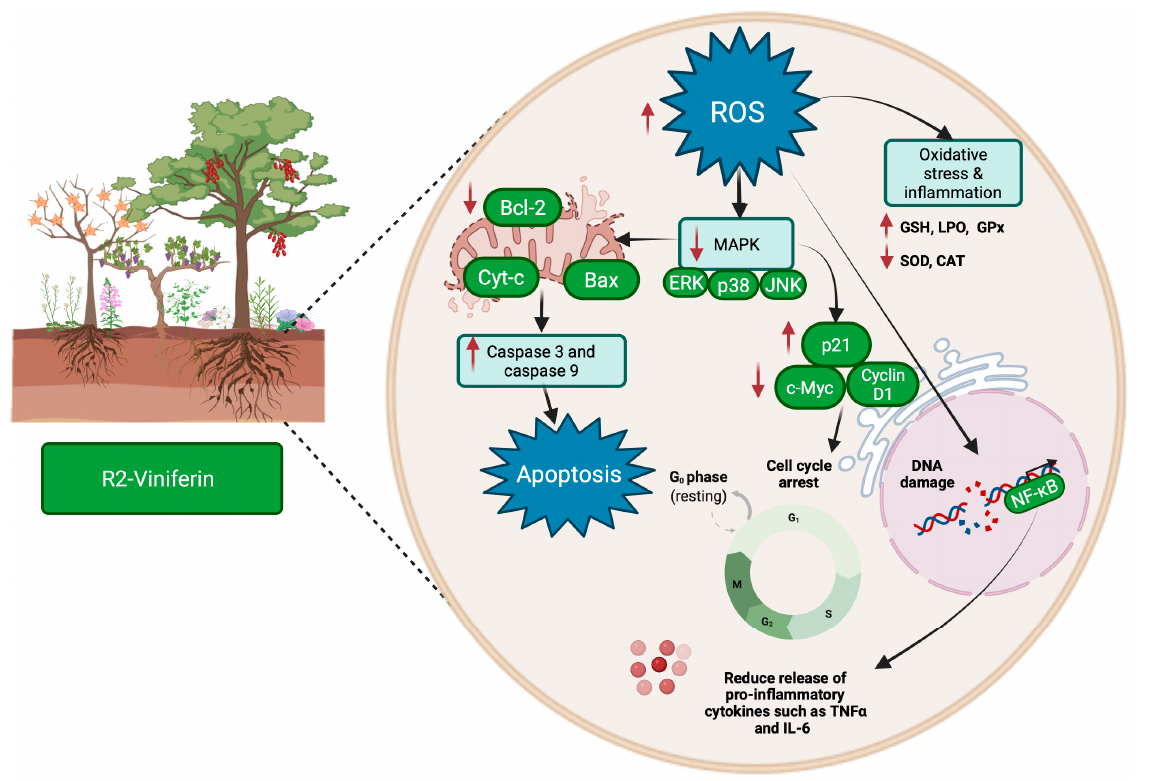
Figure 4. R2-viniferin apoptosis and inflammation-suppression mechanisms. R2-viniferin causes an increase in intracellular reactive oxygen species (ROS), thereby inhibiting the p38/ERK MAPK signaling pathway, arrests the cell cycle in G2/M and elevates the ratio of Bax/Bcl-2 proteins, predictive of apoptosis. Furthermore, the bioactive compound can also aid in lowering the level of pro-inflammatory cytokines, such as TNF α and IL-6. Abbreviations: ROS, Reactive oxygen species; MAPK, Mitogen-activated protein kinase; ERK, Extracellular signal-regulated kinase; JNK, Jun N-terminal Kinase; GSH, Glutathione; LPO, Lipid peroxides; GPx, Glutathione Peroxidase; SOD, Superoxide dismutase; CAT, Catalase; c-Myc, Cellular Homologue of Avian Myelocytomatosis Virus; NF-kB, Nuclear factor kappa B; TNF α , Tumor necrosis factor alpha; IL-6, Interleukin 6; Bcl-2, B-cell lymphoma-2; Cyt-c, Cytochrome complex; Bax, Bcl-2-associated X Protein.